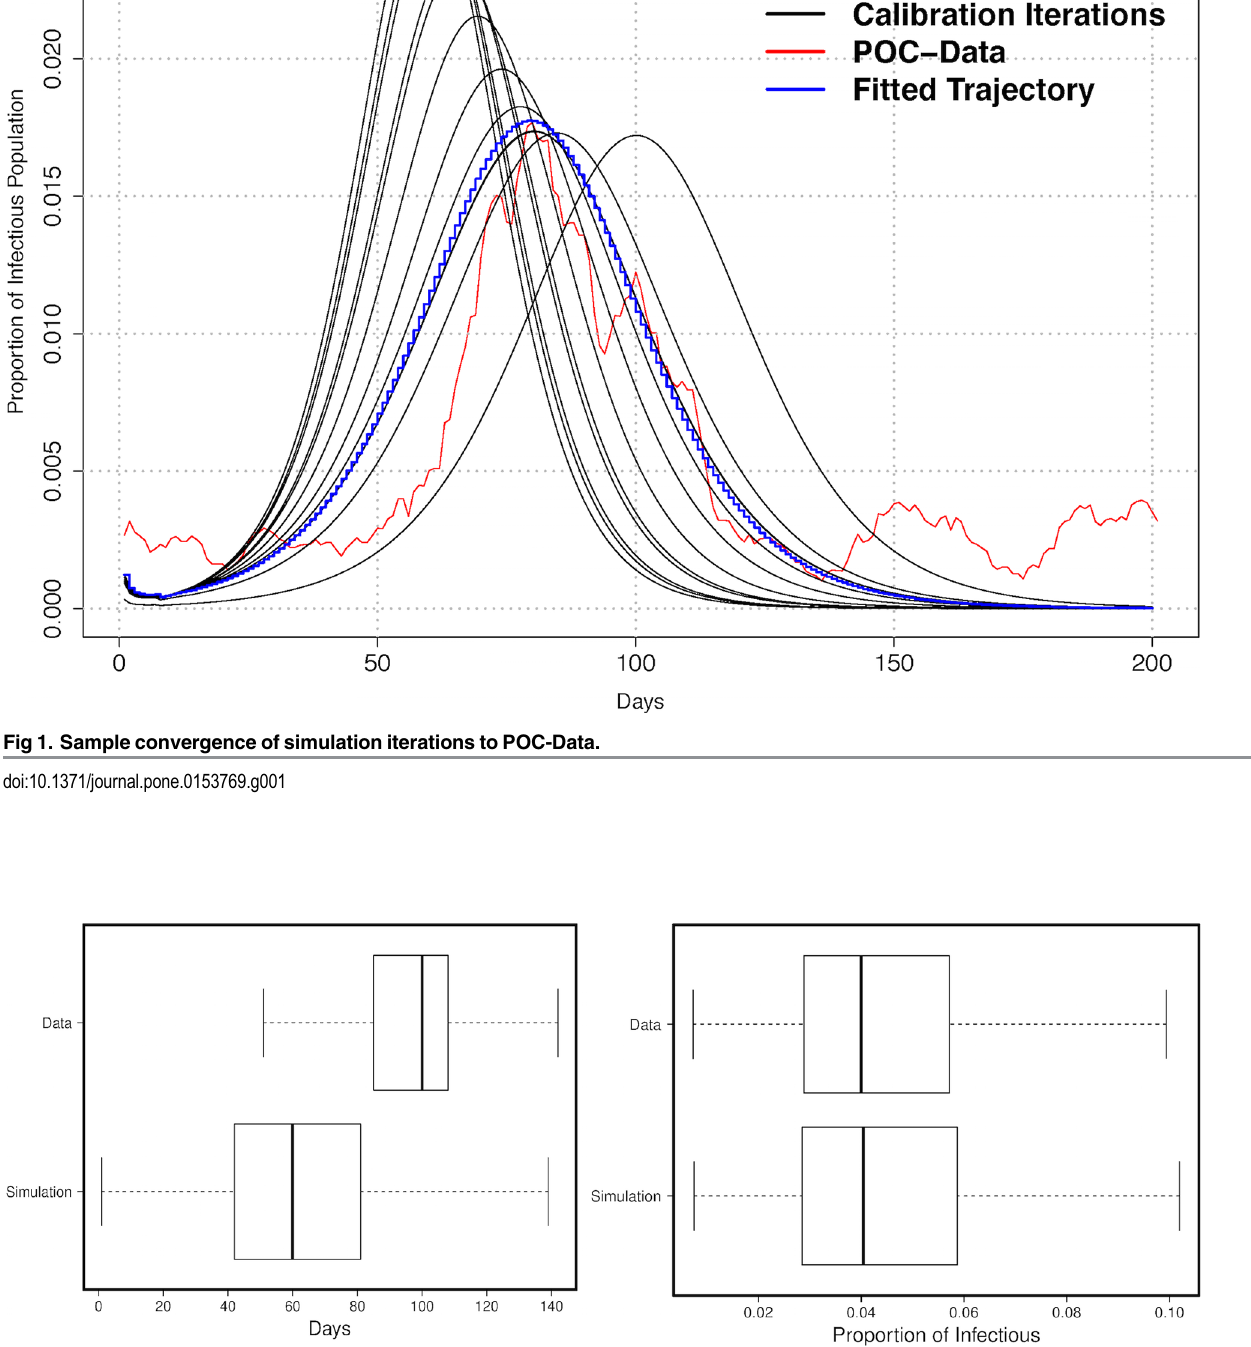
PLOS ONE | DOI:10.1371/journal.pone.0153769 April 20,